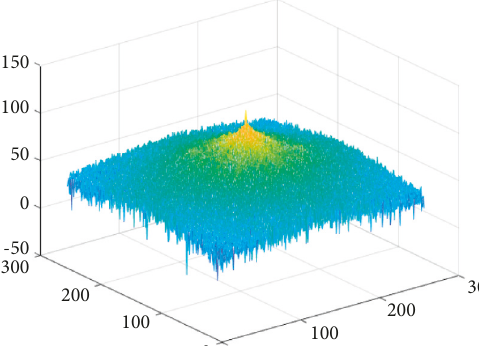
Figure 9: Mesh grid PSD estimate visualization.